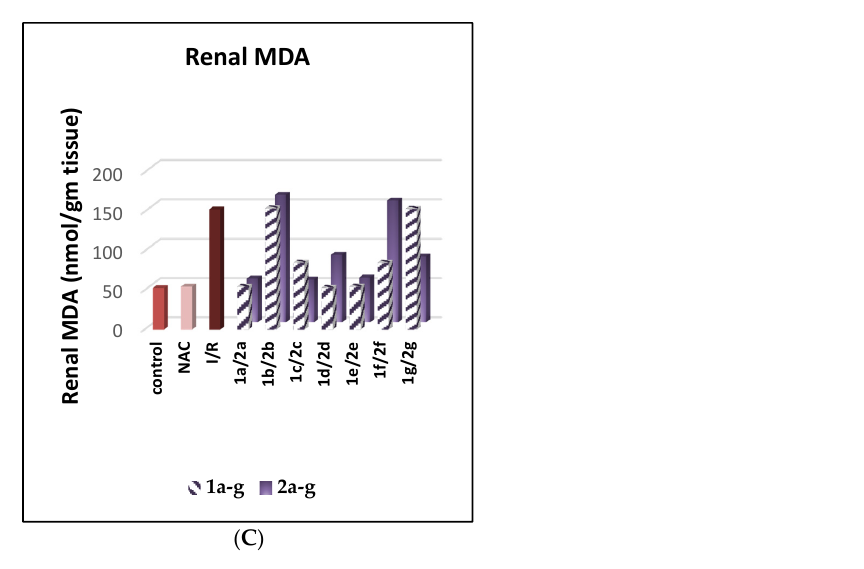
Figure 5. Concentrations of ( A ) serum creatinine (mg/dL); ( B ) serum urea (mg/dL); and ( C ) renal MDA (nmol/gm tissue) in the kidneys of I/R rats treated with cyclized thiadiazols derivatives 2a – g and their corresponding opened hydrazinecarbothioamides 1a – g in comparison with NAC (refer- ence).